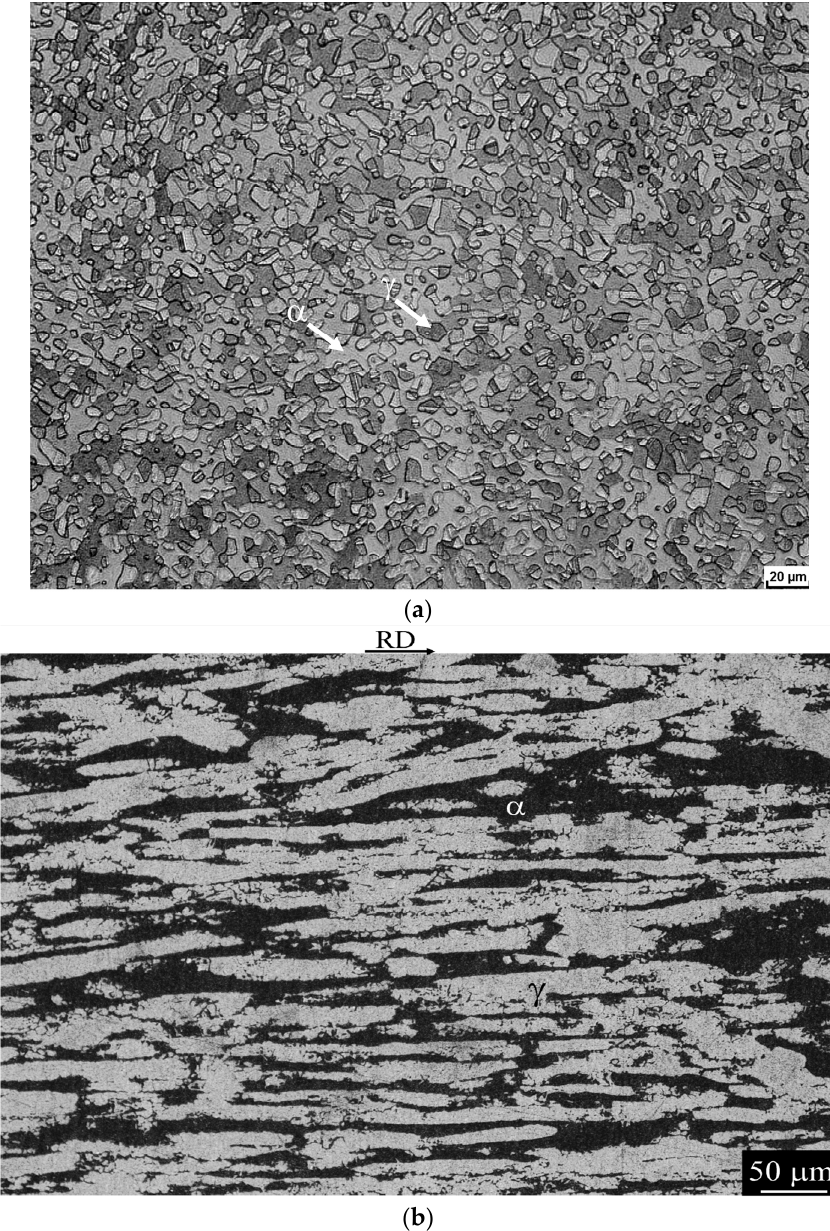
Figure 1. ( a ) As-received (AR) micrograph of duplex stainless steel (DSS), showing α -ferrite and γ -austenite. One can see equiaxial austenite grains embedded in the ferritic matrix. ( b ) AR micrograph from superduplex stainless steel (SDSS), showing α -ferrite (black) and γ -austenite (white). One can see elongated grains of both phases. RD: rolling direction.